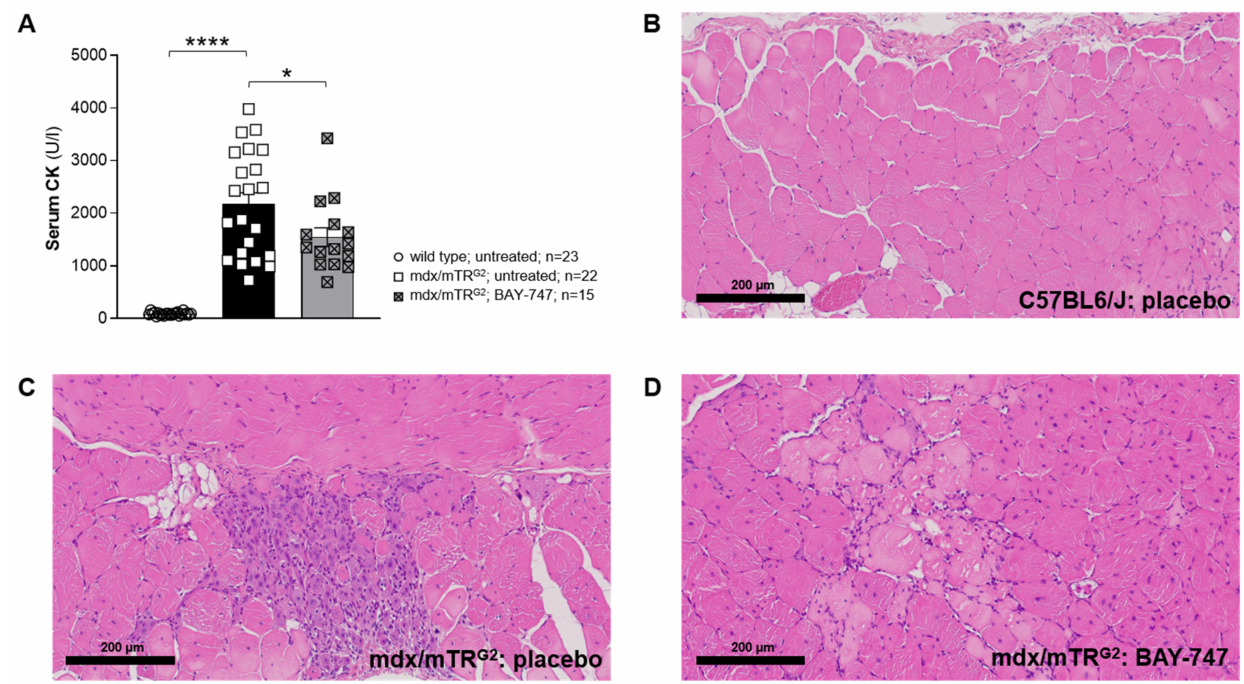
Figure 5. BAY-747 treatment reduced serum creatinine kinase but did not improve skeletal muscle pathology of mdx/mTR G2 mice. The 16-weeks of treatment with BAY-747 reduces circulating creatine kinase levels ( A ) in the mdx/mTR G2 mice compared to untreated mice. However, BAY-747 treatment for 16 weeks did not improve skeletal muscle pathology in mdx/mTR G2 mice. Representative images of H&E-stained rectus abdominis tissue sections of ( B ) wild type: untreated; ( C ) mdx/mTR G2 : untreated; and ( D ) mdx/mTR G2 : BAY-747. * p < 0.05; **** p < 0.0001; ns, not significant for one-way ANOVA followed by Dunnett’s multiple comparison post-hoc